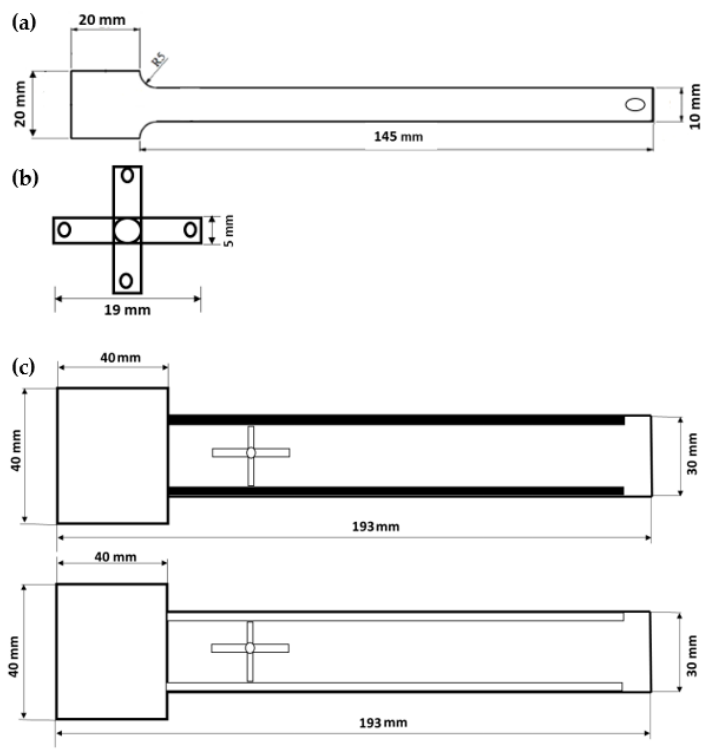
Figure 4. Geometry of specimens: ( a ) ABS simple beam; ( b ) origami capsule TPU; ( c ) Double cantilever beam (DCB (with hole and pillars).